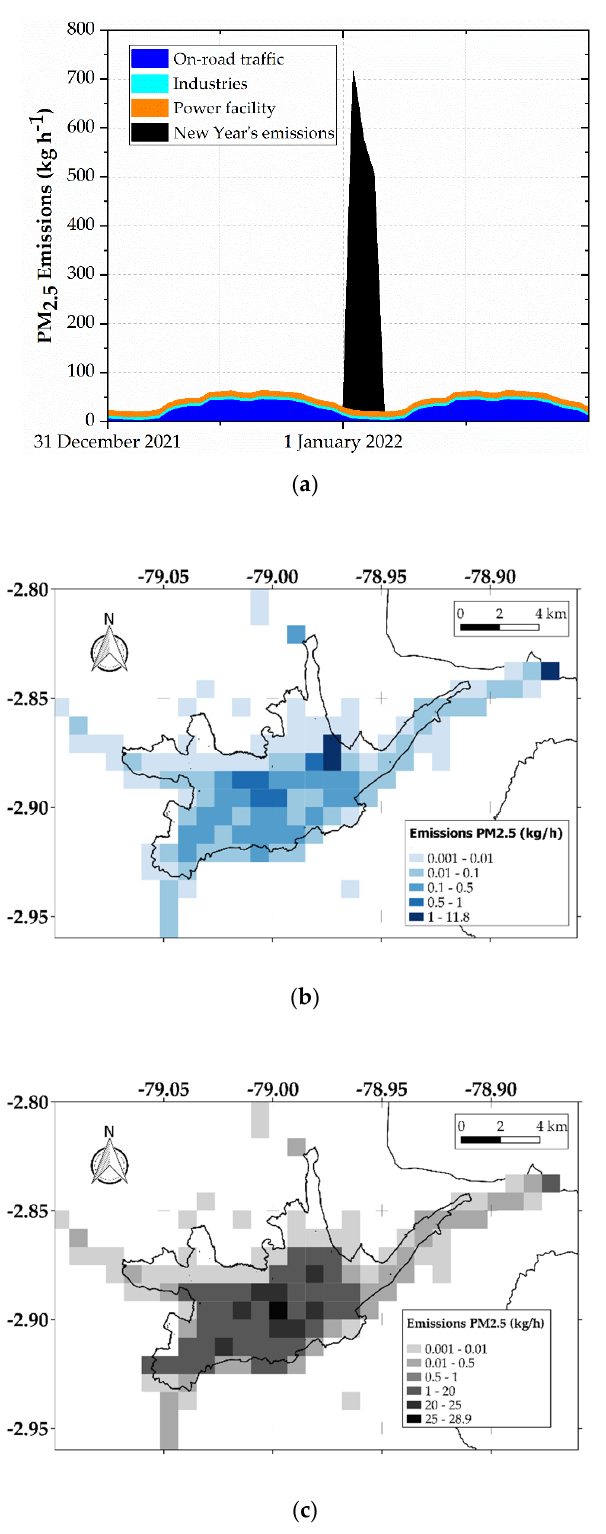
Figure 2. ( a ) Hourly emissions from 31 December 2020 to 1 January 2022 from background sources (on-road traffic, industries, and power facility) and New Year’s burning activities. ( b ) Gridded emissions on 1 January 2022 at 00:00 LT from background sources. ( c ) Gridded emissions on 1 January 2022 at 00:00 LT from background sources and New Year’s burning